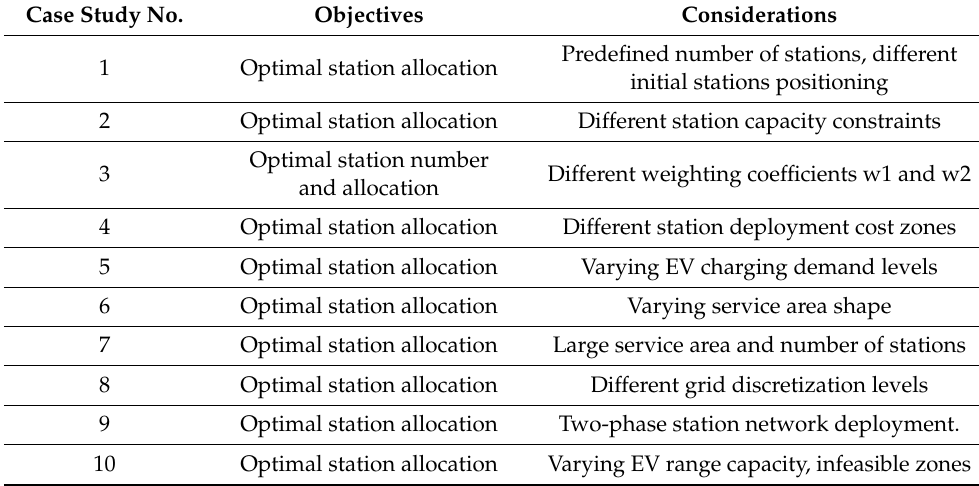
Table 1. Case study objectives and considerations.